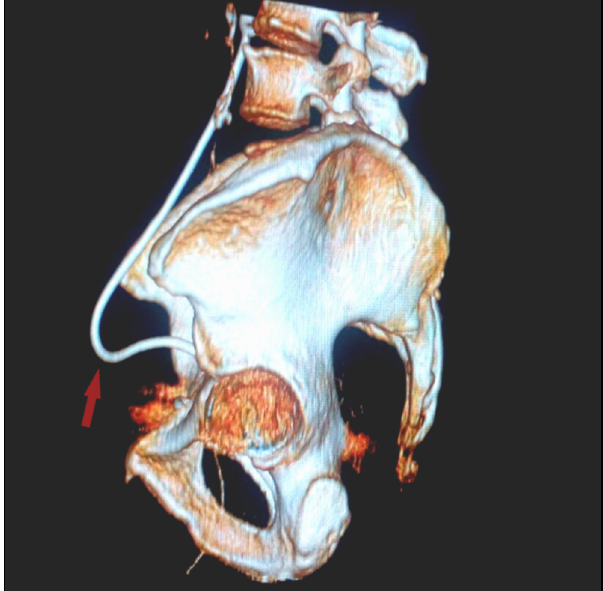
Figure 2. 3D reconstruction of the postoperative pelvic CT scan with urography. Left-lateral view of the bulged inferior 1/3 of the ureter (red arrow) towards the inguinal canal.